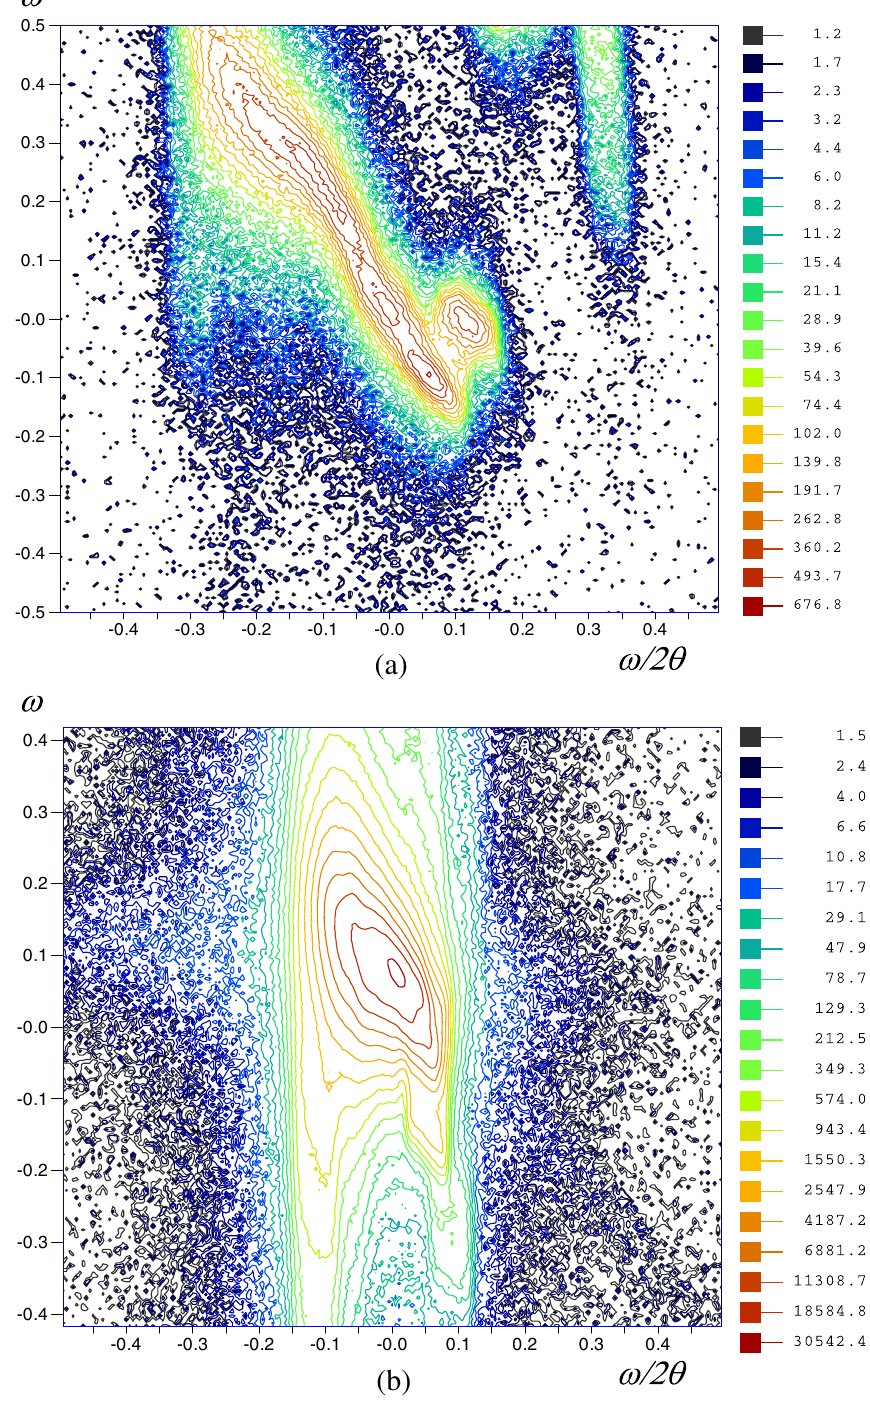
FIG. 5 (color online). Experimental RSM graph of bulk sample Nb-SC-01 as described in Table III. (a) Shallow penetration; (b) deep